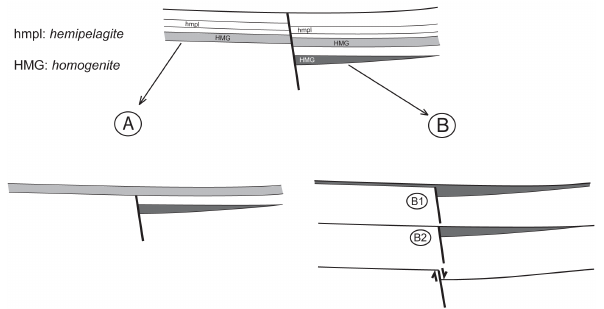
Fig. 11. Sketch of sedimentation and faulting in Core 12 area (Pro- file 76). In case A, hemipelagites (“background” sediments) and a homogenite are offset after their deposit; the homogenite does not appear related to the local active fault but may be related to a seismic triggering from a farther area; the observable offset is not necessarily co-seismic. In case B, the homogenite (instantaneous deposit issued from mass wasting) is contemporaneous of an offset; “geometrical” compensation may be partial (B1) or complete (B2); the observable offset is